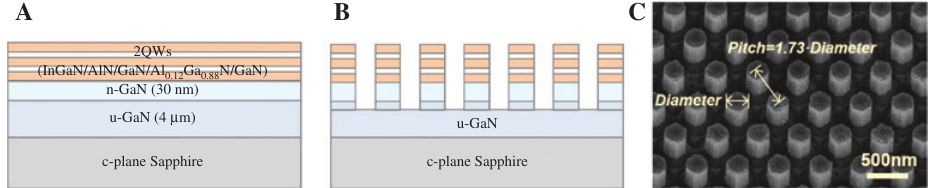
Figure 1: Schematic views of (A) the as-grown InGaN-based MQW structure and (B) the fabricated nanopillar structure, and (C) a bird-view SEM image of nanopillar MQWs (sample NP300